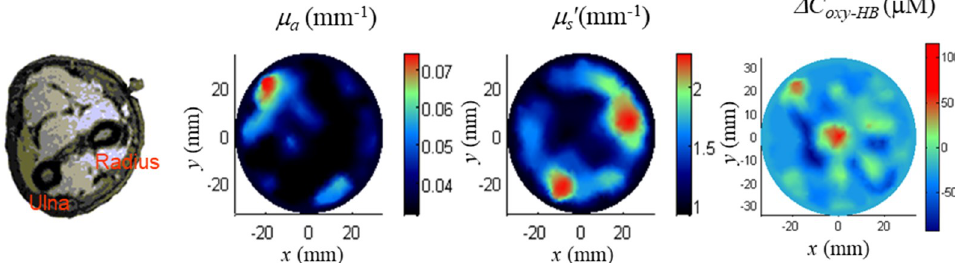
Figure 18. TD-DOT images of the human forearm. ( Left ) MRI of the forearm showing the ulna and radius. ( Center Two ) Reconstructed μ a and μ s ′ images for 759 nm at rest state. μ s ′ image reflects the positions of the two bones. ( Right ) Change in C oxy-HB from rest to task states. Red areas indicate the positions of thick blood vessels while deep-blue areas indicate muscles. Modified from Reference [47].